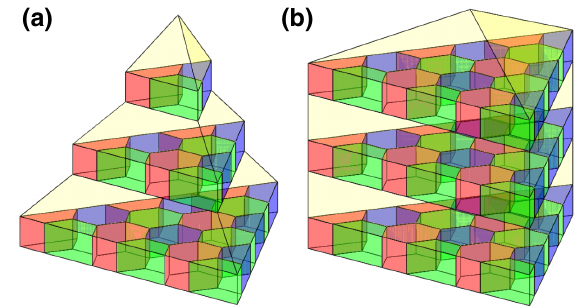
FIG. 8. (a) The recursive capped color code RCCC ( d ) with d = 7. (b) The stacked code of distance